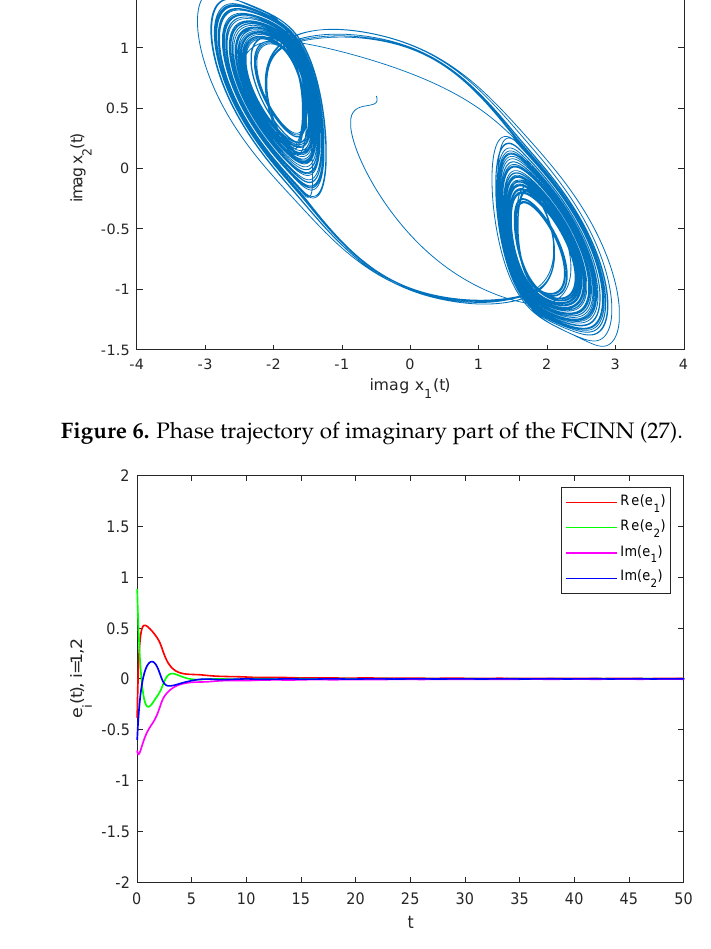
Figure 7. Time evolution of synchronization errors e 1 ( t ) and e 2 ( t ) under the controller (18). Obviously, F 1 = F 2 = 1 . Select k 1 = 1.65, k 2 = 1.34, ρ 1 = 3.31, ρ 2 = 1.66 . Then the